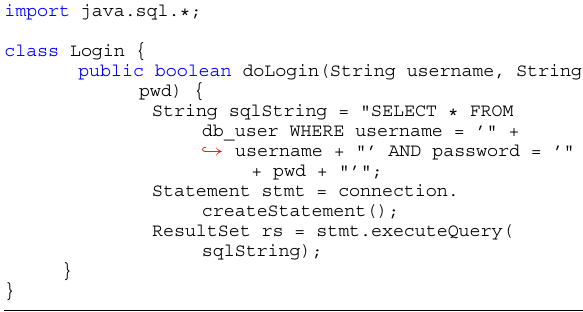
of SQLI is done in conjunction with Algorithm 2